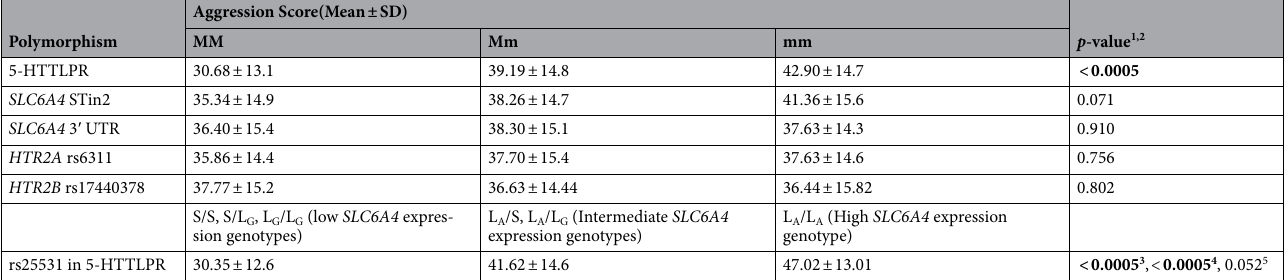
Table 4. Association of SLC6A4 5-HTTLPR, STin2, 5-HTT 3 ʹ UTR, rs25331 in 5-HTTLPR and HTR2A rs6311 polymorphism with aggression score in sentenced murderers. M, major allele; m, minor allele. 1 Bonferroni correction for multiple testing was applied ( p -value threshold 0.0125). Statistically significant p -values (< 0.01) are highlighted in bold. 2 Recessive model for all the polymorphisms (MM and Mm vs. mm). 3 S/S, S/L 4 S/S, S/L 5 L G , L G /L G vs. L A /S, L A /L G . G , L G /L G vs. L A /L A . A /S, L A /L G vs. L A /L A